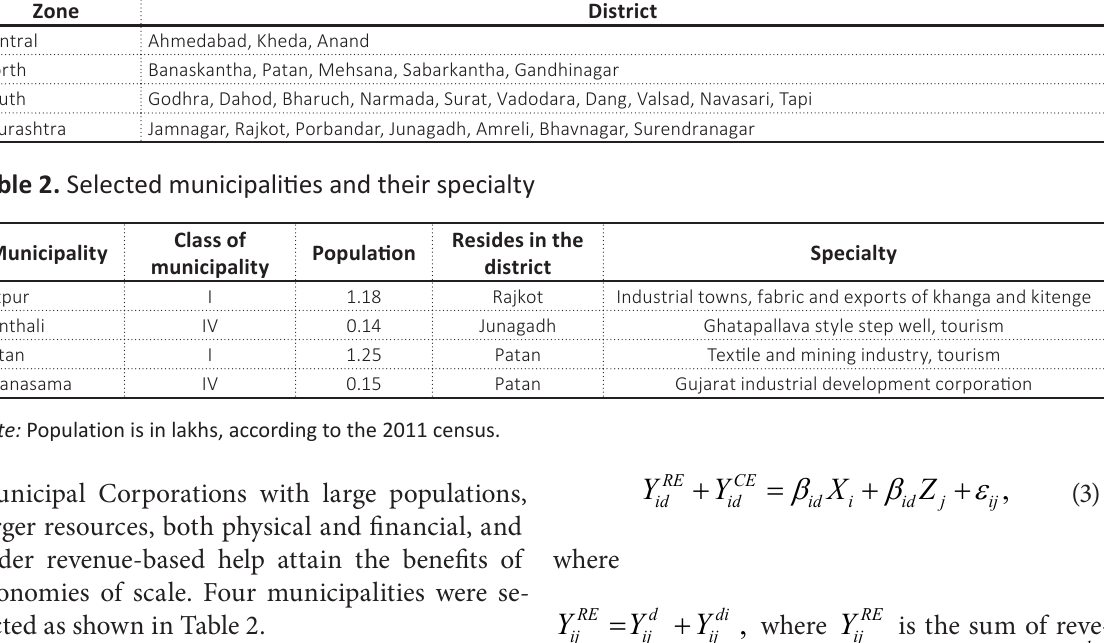
Table 1. Selected zones and districts of Gujarat